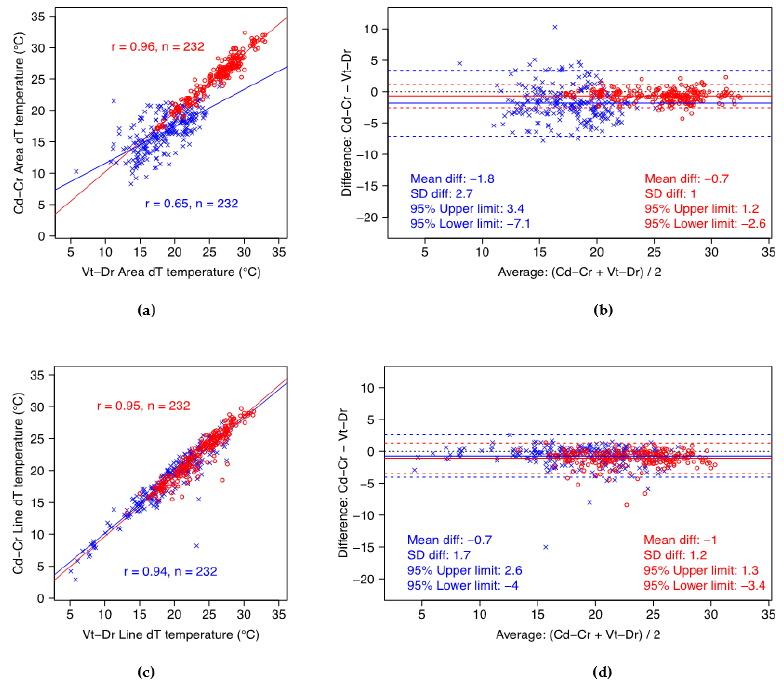
Figure 3. Scatterplots summarizing Pearson’s correlation ( r ) between projections (left side) and Bland–Altman plots (right side) for quarters (top row—( a , b )) and teats (bottom row—( c , d )) at 2nd IRT. Cd-Cr—caudocranial projection; Vt-Dr—ventrodorsal projection; dT—temperature gradient; —‘min’ temperature gradient; o—‘max’ temperature gradient.